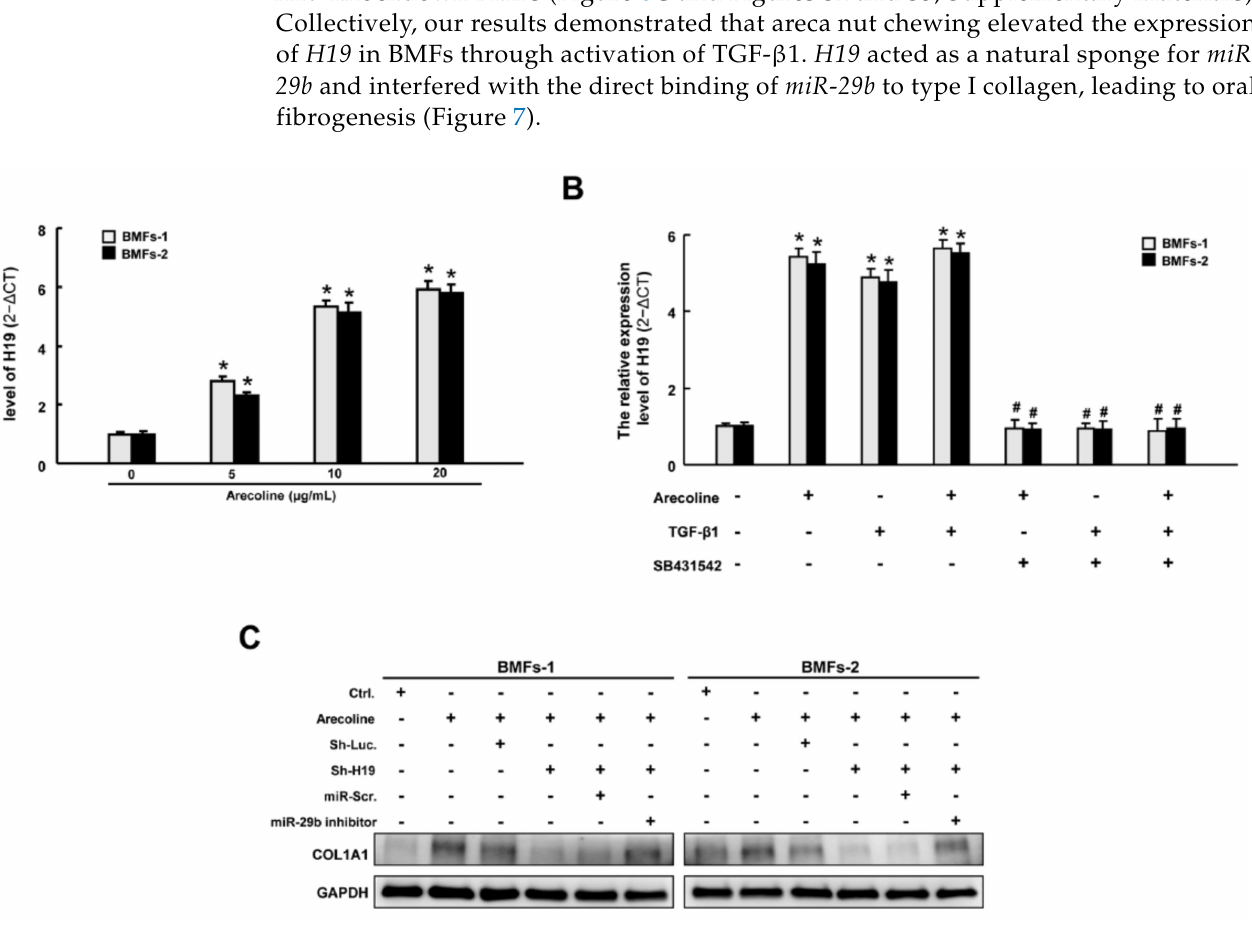
Figure 6. Arecoline increased the expression of H19 through transforming growth factor (TGF)- β 1. ( A ) The expression of H19 was increased following arecoline stimulation in a dose-dependent manner. ( B ) Relative expression of H19 in BMFs treated with arecoline, TGF- β 1, or SB431542 (a specific inhibitor of the TGF- β type I receptor). * p < 0.05 compared to no treatment. # p < 0.05 compared to arecoline treatment. ( C ) Western blotting analysis describing the expression levels of COLA1 with indicated